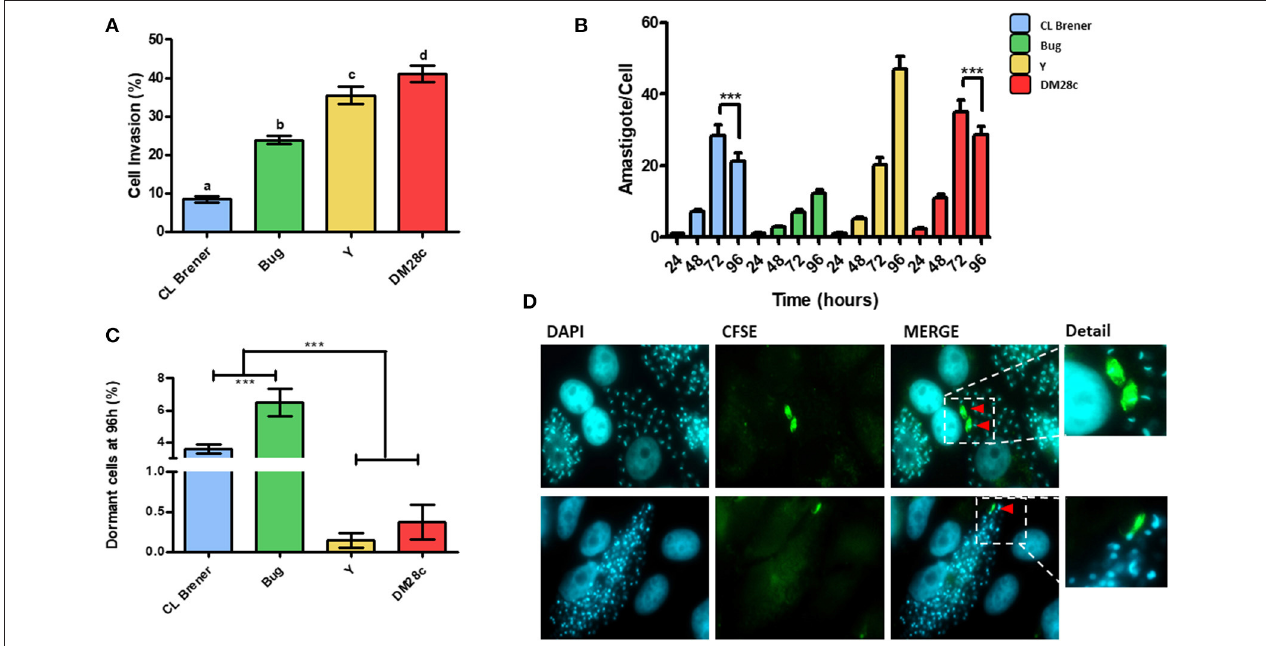
FIGURE 3 | Dormancy in amastigote forms of T. cruzi . (A) Invasion rate of CL Brener, Bug, Y, and Dm28c strains in LLC-MK2 cells. The graph shows the percentage of infected LLC-MK2 cells in a total of 250 cells were analyzed (parasites labeled with anti- T. cruzi antibody were disregarded). Letters indicate statistically significant differences among each strain ( P -value < 0.05). (B) T. cruzi infection progression. The graph shows the number of intracellular parasites per infected cells. A total of 100 infected LLC-MK2 cells were analyzed at each time point. Asterisks represent the statistically significant differences at 96h post infection in CL Brener and Dm28c when compared to 72h post infection ( P -value < 0.05). (C) The graph shows the percentage of intracellular amastigotes in a dormant state 96h post-infection. A total of 100 LLC-MK2 infected cells were analyzed. Asterisks indicate statistically significant differences among groups ( P -value < 0.05). (D) Representative images of DM28c infected cultures, 96h post-infection. Red arrows indicate dormant (CFSE + ) amastigotes (upper panel) and CFSE positive trypomastigotes (lower panel) (100x). The CFSE + amastigote and trypomastigote form were detailed. Representative results of two distinct experiments in three technical repetitions